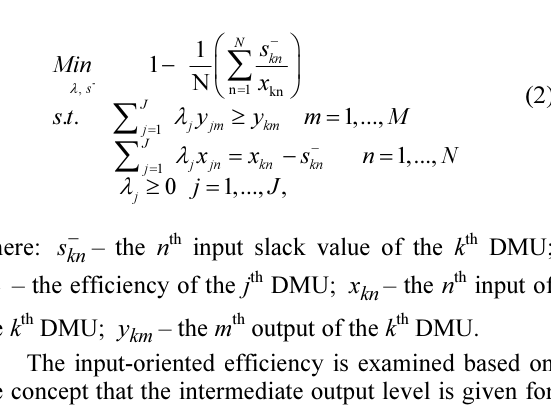
Fig. 1. Schematic diagram of traditional single-stage non- oriented SBM model